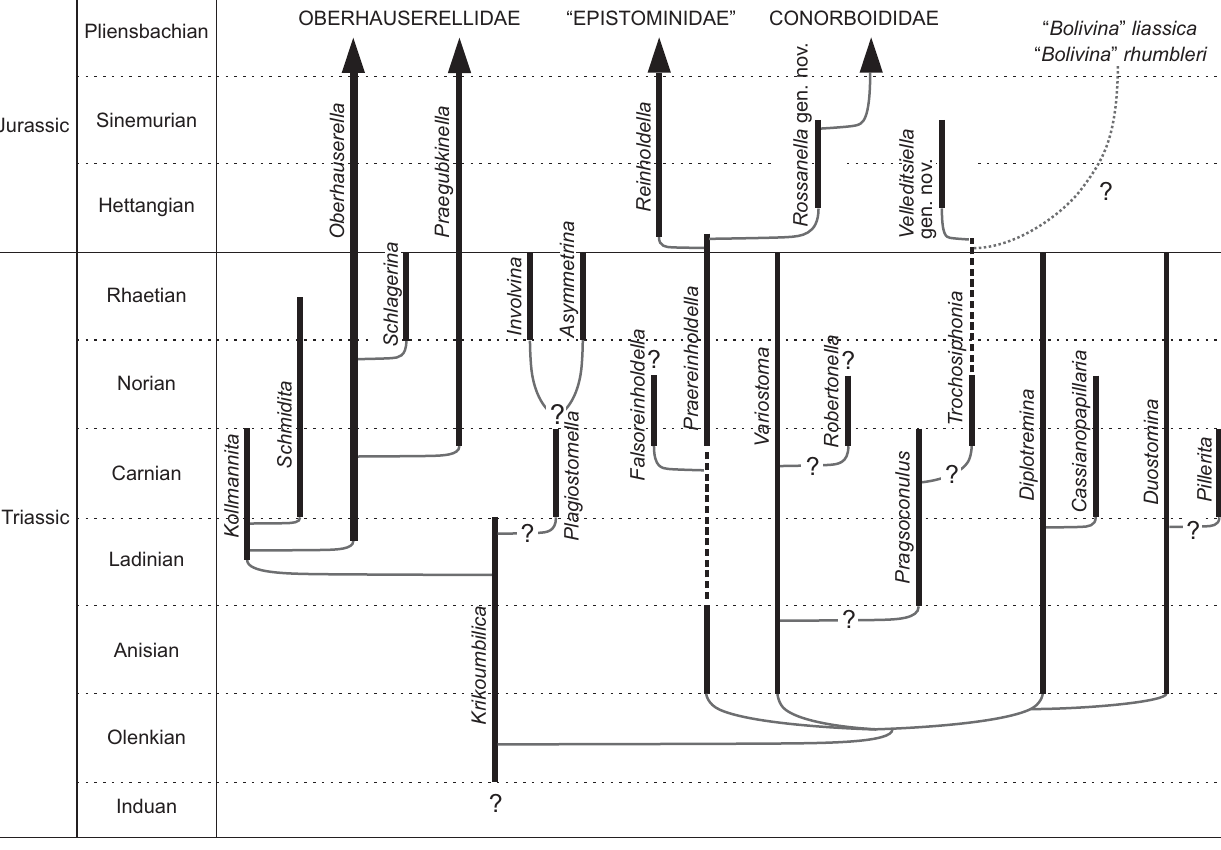
fig. 1 as “ Reinholdella sp. A” and Hillebrandt 2012: pl. 4: 1, 4, 5; pl. 6: 3a, b as “cf. Reinholdella sp. nov.”). This species